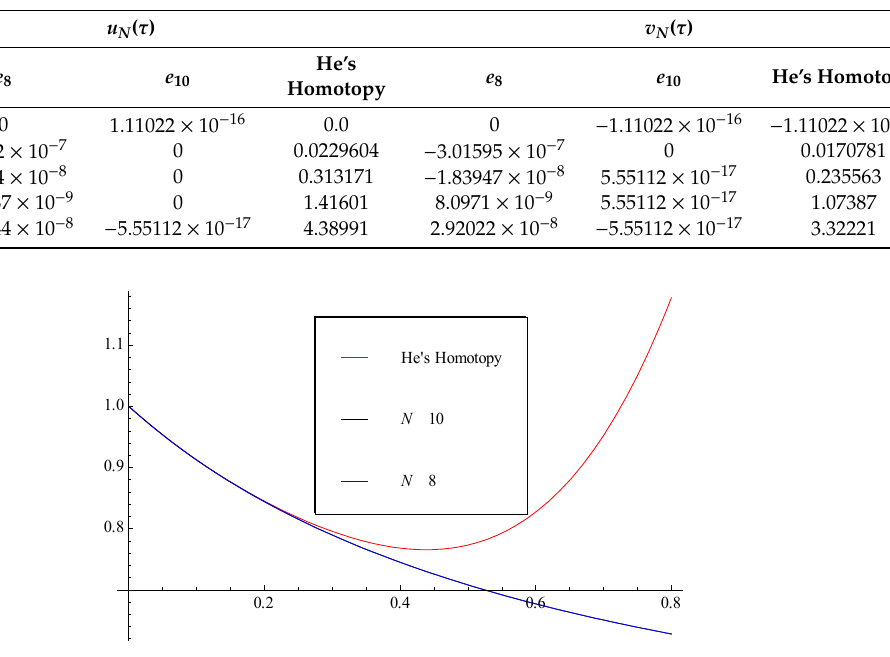
Figure 4. Approximate solutions u N ( τ ) at di ff erent N with He’s Homotopy Figure 4 . Approximate solutions at different N with He’s Homotopy solution.